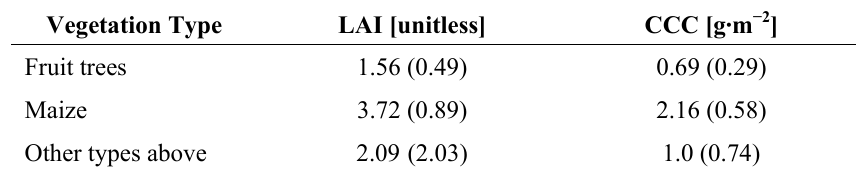
Table 2. Mean values (and standard deviation) of LAI and CCC field